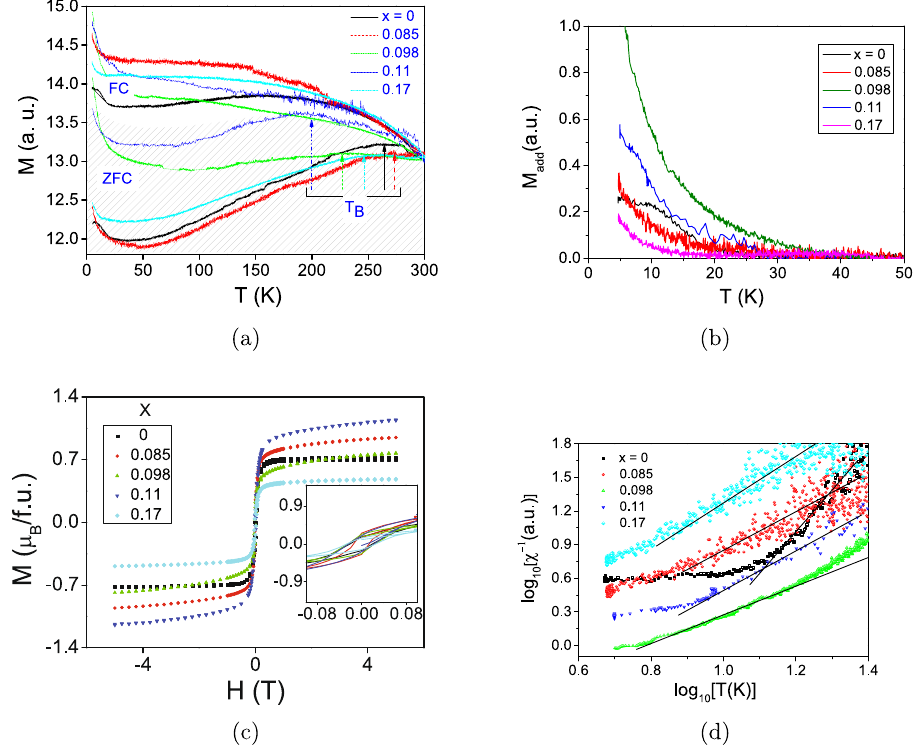
Figure 6. ( a ) FC and ZFC magnetizations versus temperature at 500 Oe field for x = 0.000, 0.085, 0.098, 0.11 and 0.17. The curves have been vertically shifted for clarity. The region containing essentially the ZFC curves is hatched for visual separation between FC and ZFC curves. Approximate blocking temperature ( T B ) is also marked for each case. ( b ) M add versus T curve. ( c ) M-H curves at 2 K for x = 0.000, 0.085, 0.098, 0.17 and at 5 K for x = 0.11. Inset: Low-field region of the M-H curves showing hystereses. ( d ) χ − Log( ) 5 K–25 K region. Since the data in this plot are derived from ( a ) with vertical shifts, they are also shifted accordingly in this